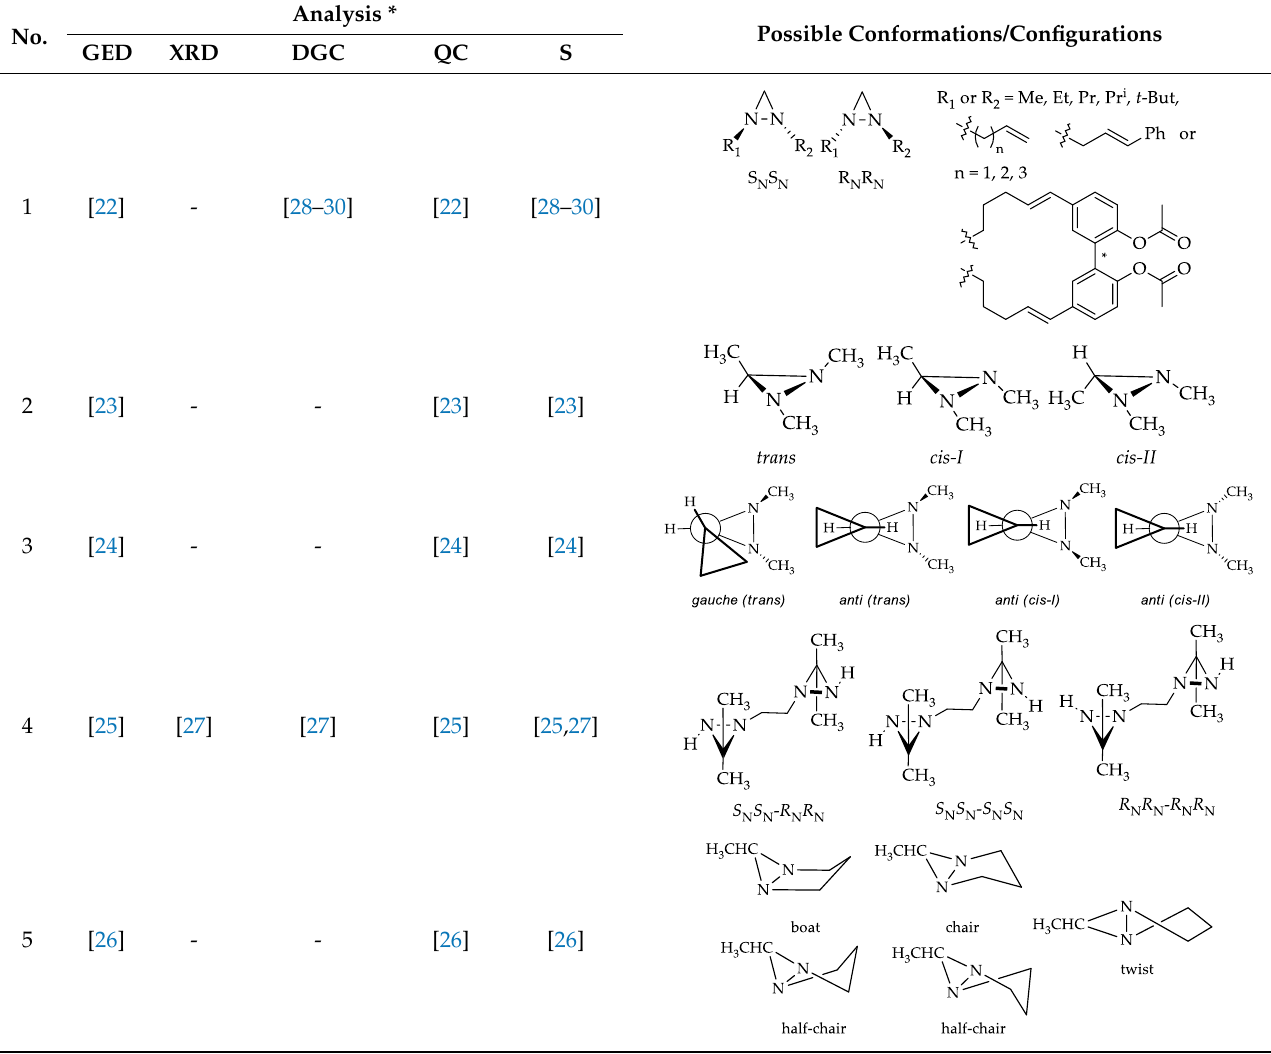
Figure 2. General construction of monocyclic diaziridines.